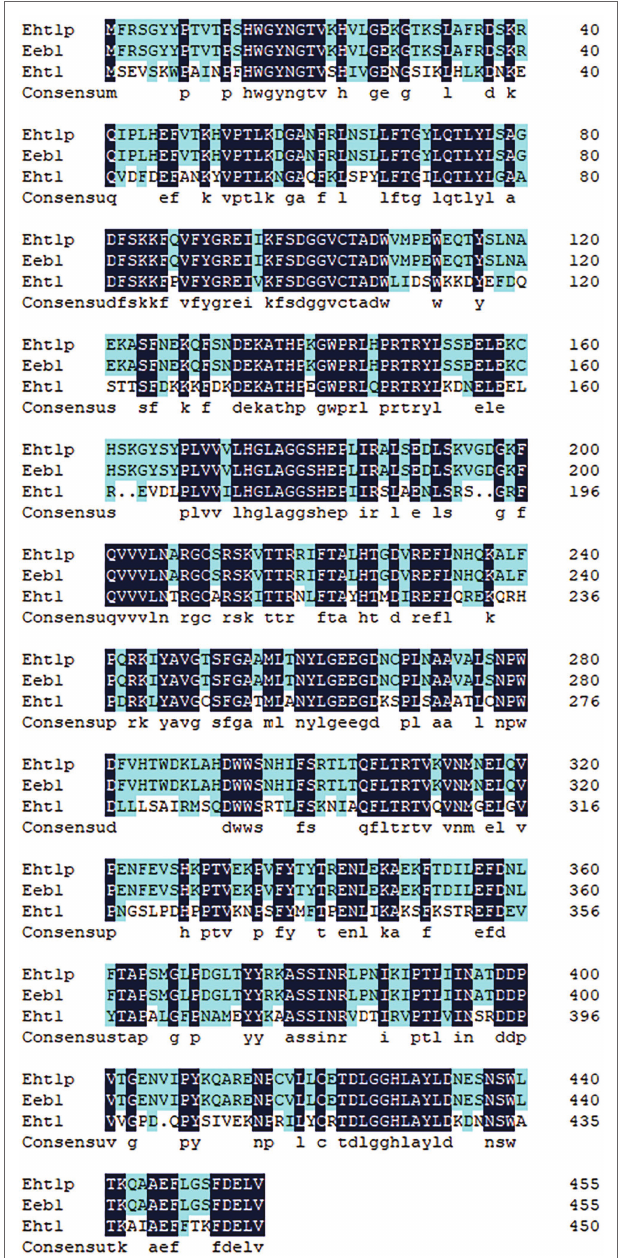
FIGURE 7 | Multiple comparisons of Eht1p, Eeb1 and Eht1 amino acid sequences of Wickerhamomyces anomalus Y-1. Non-conservative residues are black text on a white background. Conservative same residue as white text on dark blue background. A similar residue is a black text on a light blue